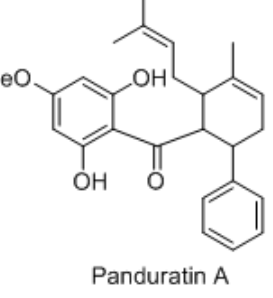
Figure 1. Chemical structure of panduratin